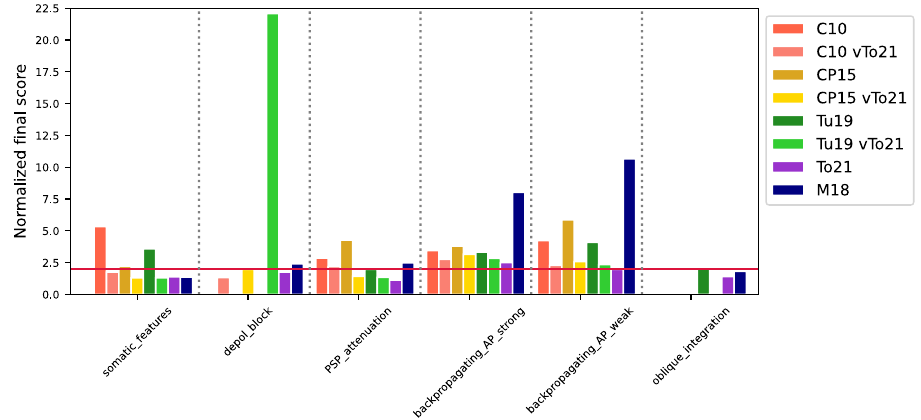
Figure 6. The final error score of all models achieved for each test. The final error score for a given test is expressed as the average of the errors of all tested features (see Methods). If the model does not pass the test, it is indicated by a blank space. The figure also contains the final scores from the modified reduced-morphology models labeled as "vTo21" at the end of the model name in the legend (see text for more details). The red horizontal line represents sd = 2 .